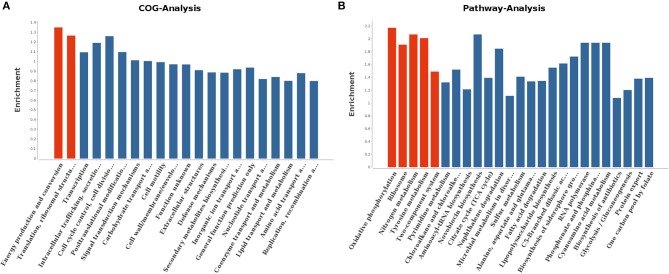
COG analysis (A) and KEGG pathway analysis (B) for differentially expressed genes. The red columns indicated these categories or pathways were significantly enriched (p < 0.05) while the blue columns means these categories or pathways were not significantly enriched.